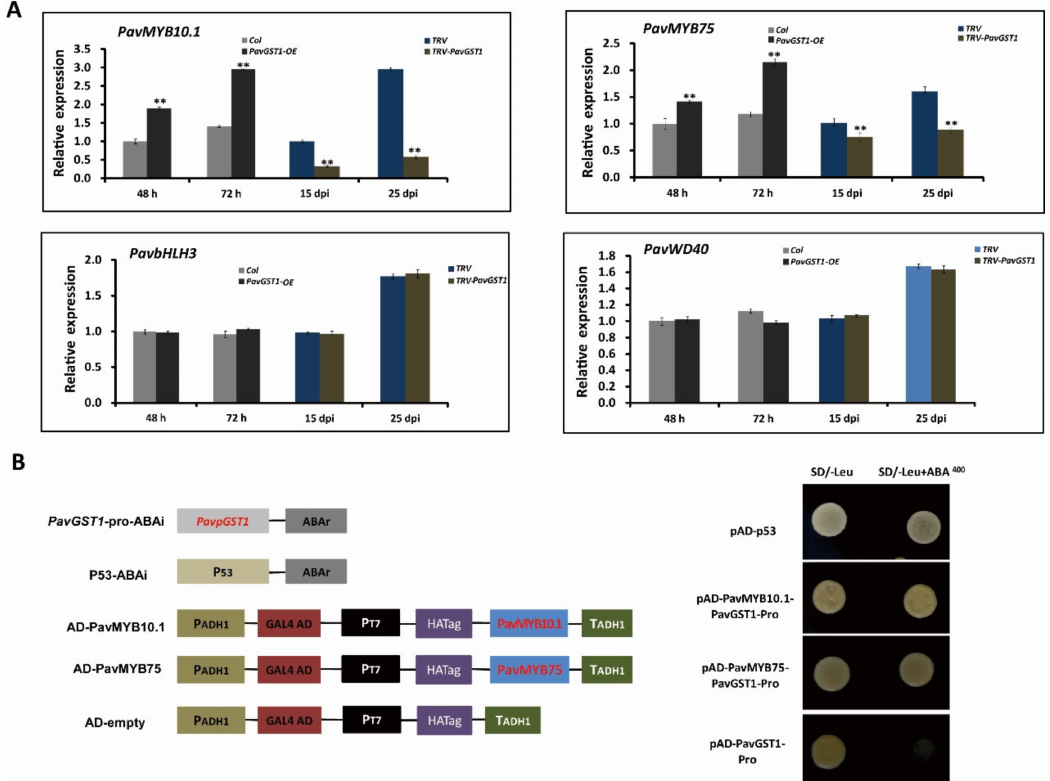
Figure 6. Data showing that PavMYB10.1 and PavMYB75 expression levels are regulated by PavGST1 and their direct binding to the PavGST1 promoter. ( A ) Changes in transcript levels of PavMYB75 , PavMYB10.1 , PavbHLH3 , and PavWD40 genes in PavGST1 -overexpressing and PavGST1- silenced sweet cherry fruits. ( B ) Results of yeast one-hybrid (Y1H) assays showing PavMYB10.1 and PavMYB75 individually bound to the PavGST1 promoter. Values represent means ± SD from six independent replicates. Statistical significance was determined according to one-way analysis of variance (ANOVA, **, p <